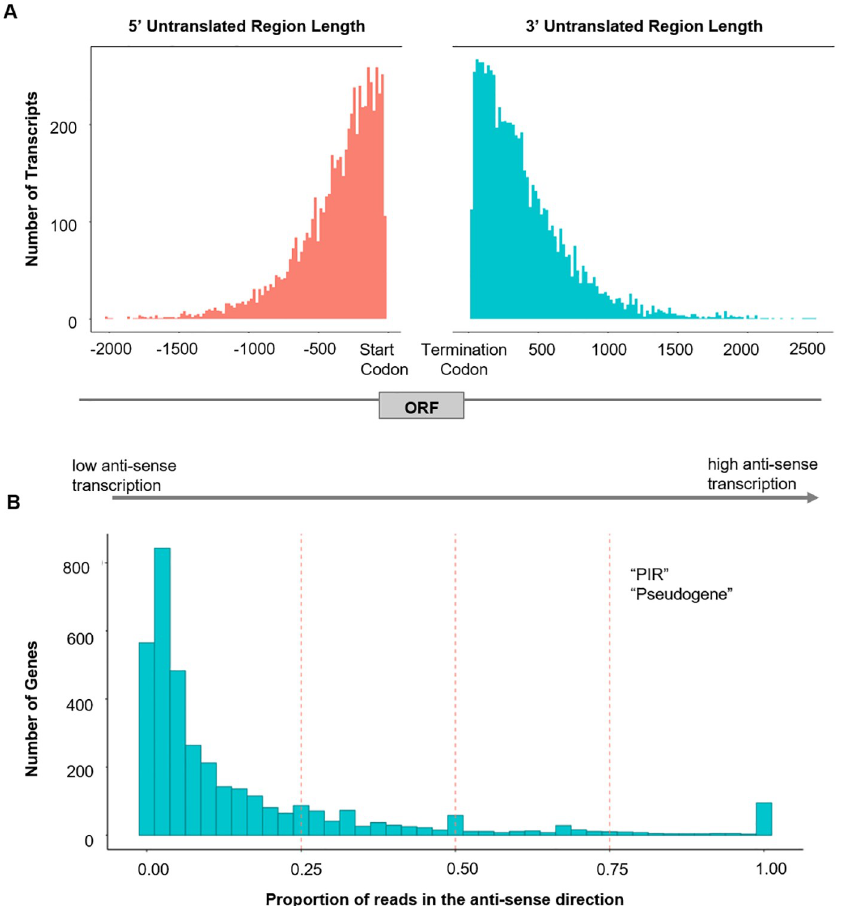
Fig 3. Trends in UTR length and anti-sense transcripts. (A) A histogram depicting the number of UTRs reaching each length (in bp) from all ORF predictions of assembled transcripts. To denote distance from coding section of the gene, five prime UTRs (left) were given negative values while three prime UTRs (right) were given positive values. The gene model on the bottom is depicted merely for visualization. (B) Distribution of proportion anti-sense reads by gene. Dotted lines separate genes into ranges and terms for each group represent terms significantly enriched (P > 0.05, Bonferroni-adjusted) within genes of that